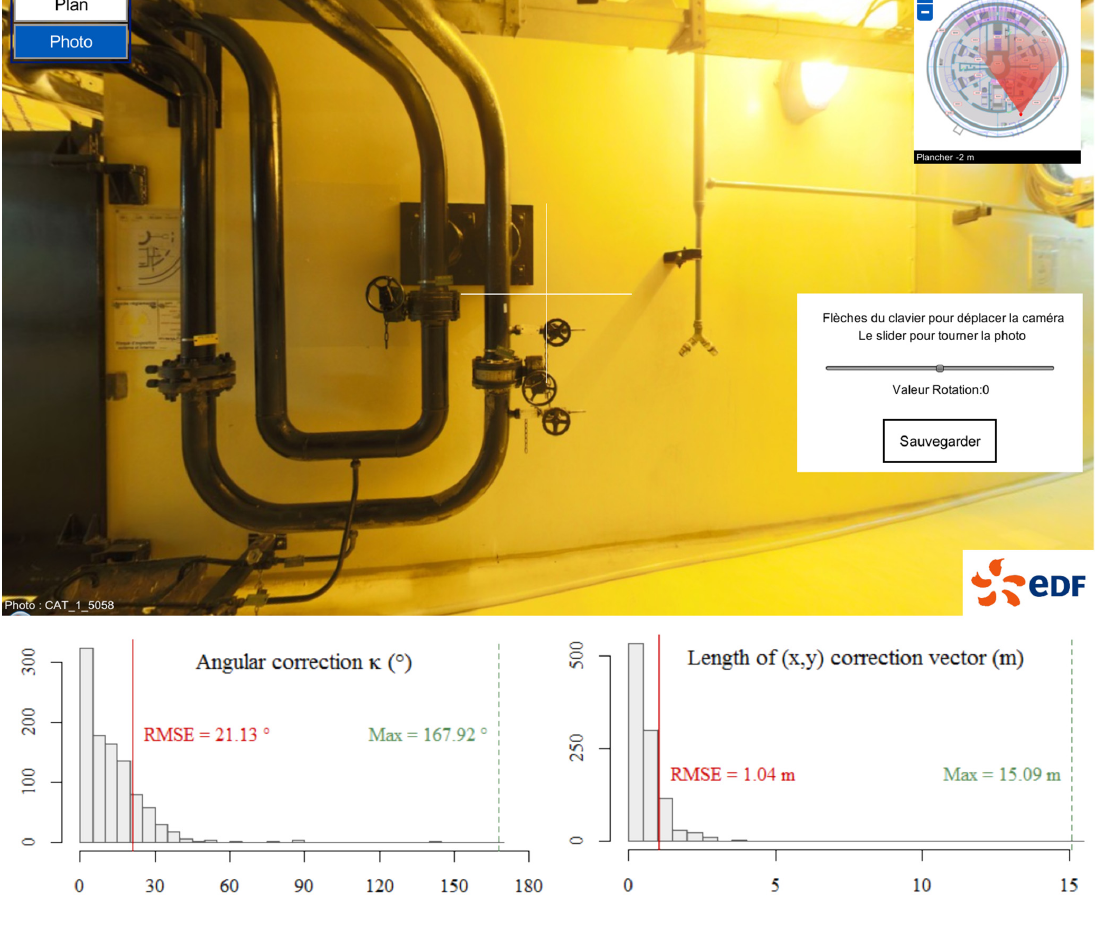
Figure 12. User interface of the partial pose estimation tool. The camera position, orientation and field of view of the panoramic image are synchronized with the floor map ( Top ). A central cross helps the sighting of landmarks. Key numbers of the corrections using 2D maps (1025 images) ( Bottom ).